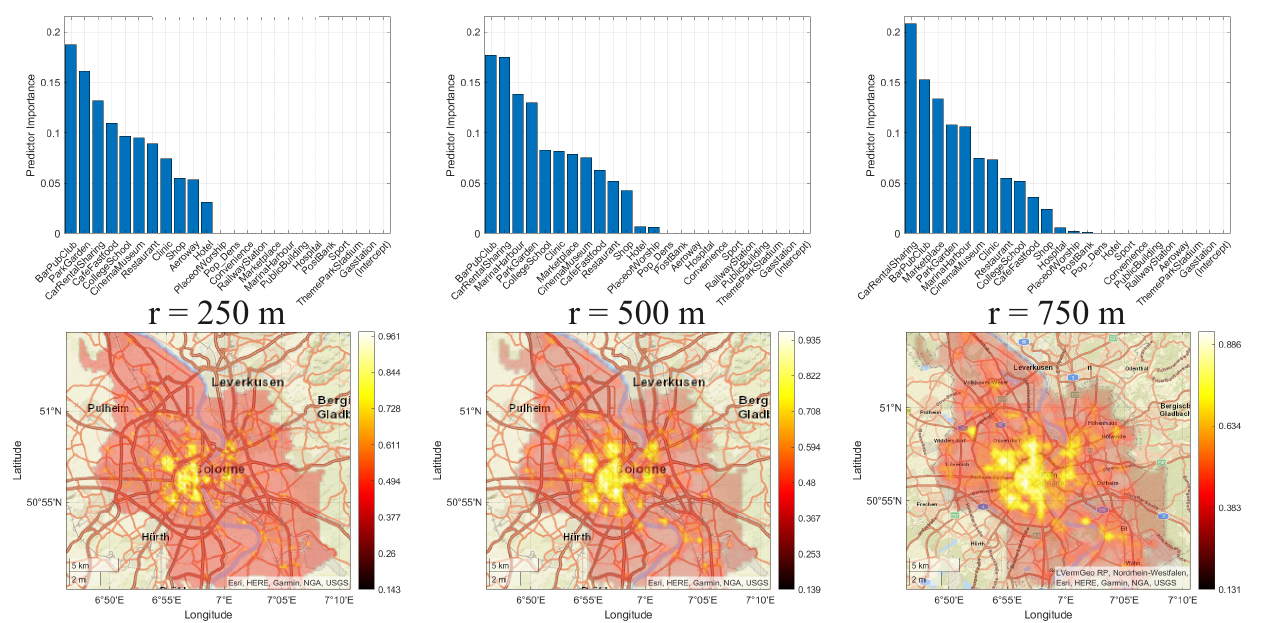
Figure A1. ( Top ): Predictor estimates of the linear regression for different values of r . The values are normalized for comparison. ( Bottom ): Example heat maps of cologne for different r